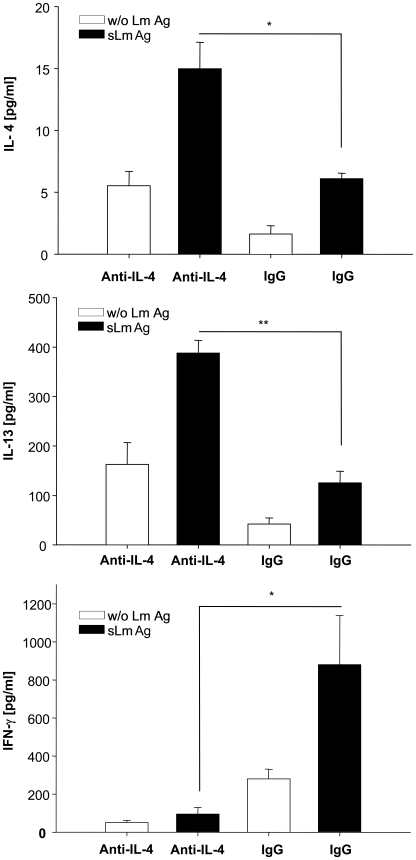
Early anti-IL-4 treatment induces a Th2 switch.IL-4, IL-13 and IFNγ secretion of CD4+ cells isolated one week after infection from draining lymph nodes of C57BL/6 mice which had been injected with 1 µg of neutralizing anti-IL-4 or irrelevant antibody into the infected footpad at the time of parasite inoculation and 4h later. Cells were incubated for 48 h with syngenic DC stimulated for 48h with soluble Leishmania antigen (sLmAg) (black bars) or with unstimulated syngenic DC (open bars). Cytokines in culture supernatants were assayed by cytometric bead assay (mean ± SE, n = 3) * = p<0.05, ** = p<0.01, Student's t-test.